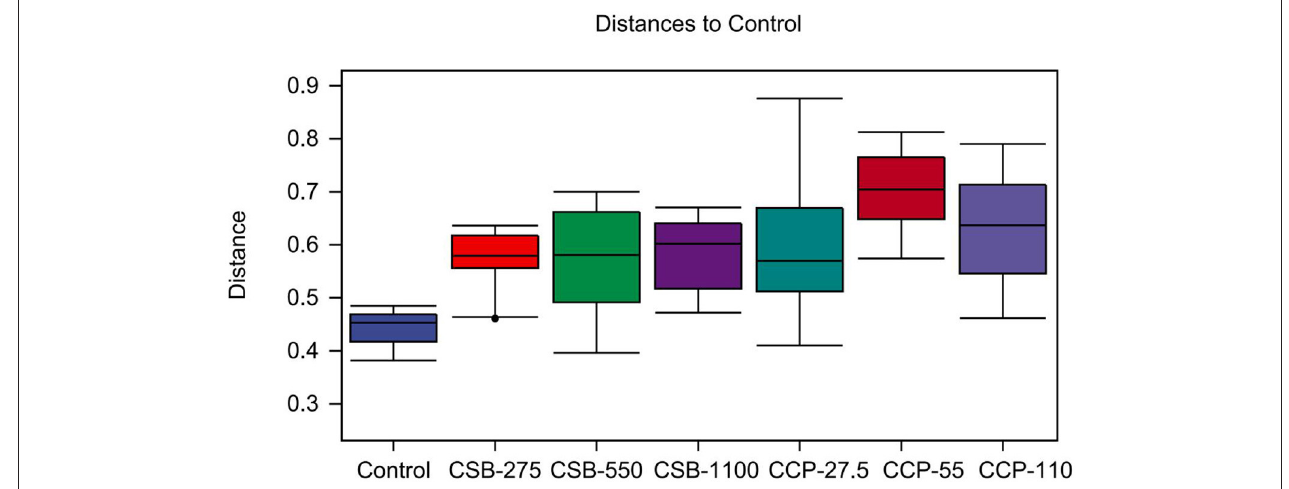
FIGURE 4 | Unweighted UniFrac distances for within and between study comparisons. It mainly reflects the analysis of differences between